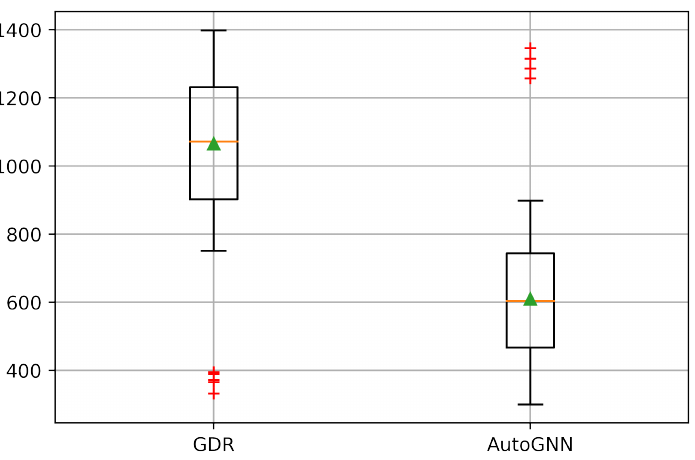
Figure 13. Evaluation on network with 40